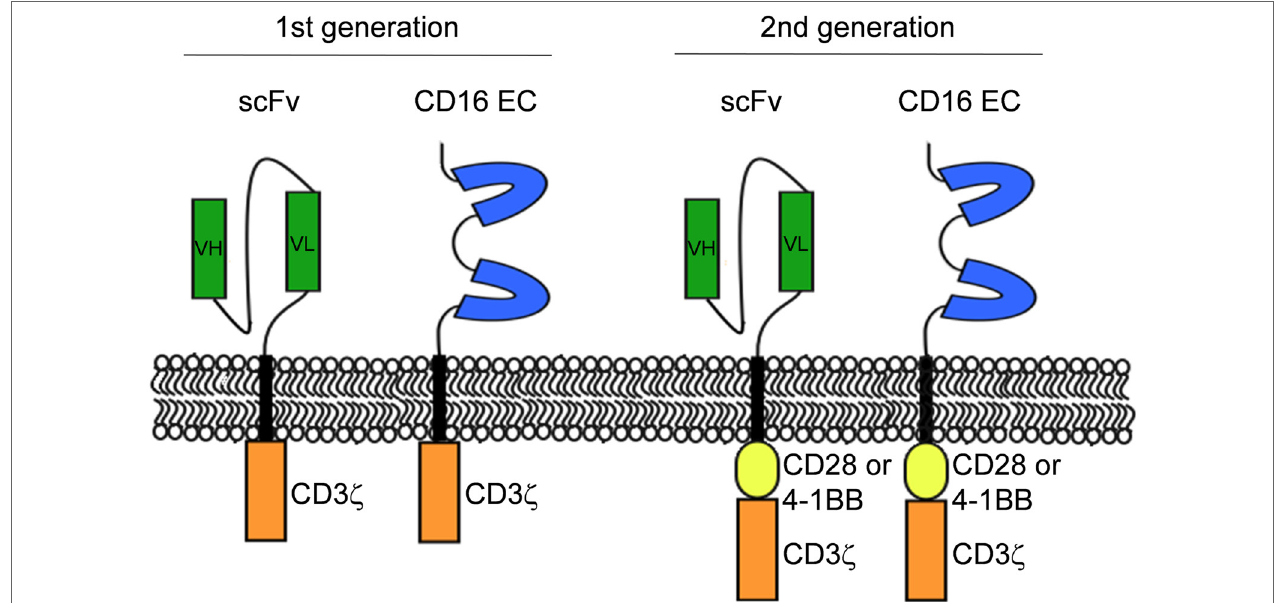
FiguRe 1 | Schematic representation of CD16-CR and classical chimeric antigen receptor molecular structures . The first generation of CR has the extracellular domain linked to the intracellular signaling motif of CD3 ζ chain while the second generation of CR has an additional co-stimulatory endodomain derived from CD28 or 4-1BB linked to the N-terminal of CD3 ζ